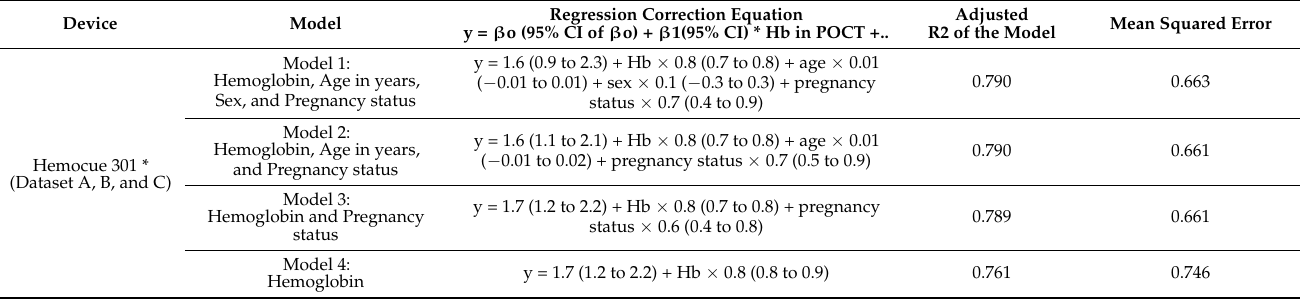
Table 2. Correction equation based on multivariable linear regression for each type of point-of- care